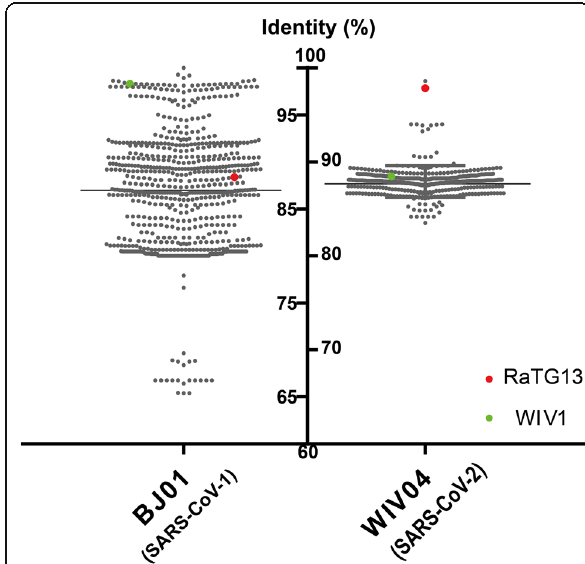
Fig. 2 Genetic diversity of bat SARSr-CoVs. Partial RNA-dependent RNA polymerase (RdRp) sequences downloaded from NCBI database were aligned to the corresponding regions from SARS-CoV-1 (BJ01, accession number AY278488.2) or SARS-CoV-2 (WIV04, accession number MN996528.1). Their sequence identity to reference were showed. Bat SARSr-CoVs WIV1 (accession number KC881006.1) and RaTG13 (accession number MN996532.2) were highlighted in green or